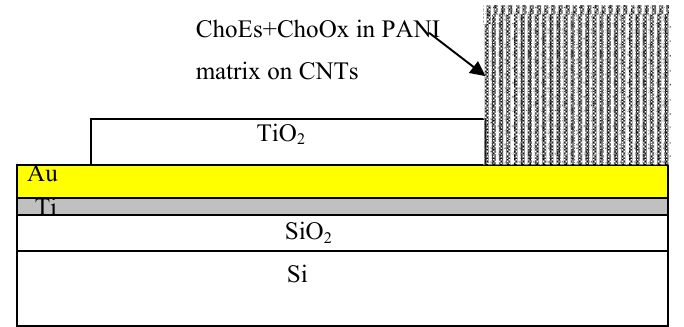
Figure 1. Structure of the CNT based cholesterol